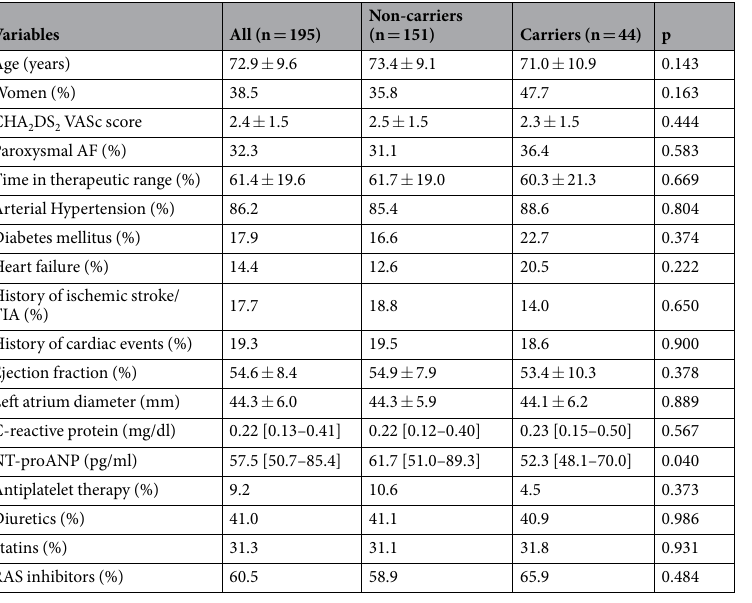
Table 1. Baseline characteristics of the patients. Continuous data are expressed as mean ± SD or as median with interquartile ranges (CRP and NT-proANP). RAS: Renin-Angiotensin System; TIA: transient ischemic attack; AF: atrial